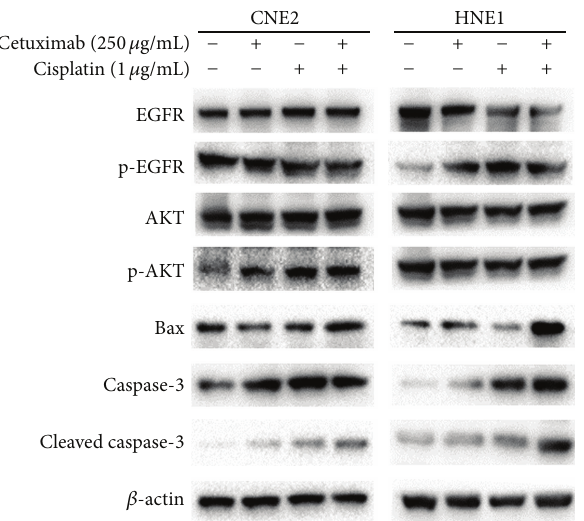
Figure 4: Effects of combination treatment with cetuximab and cis- platin on the expressions of proapoptosis proteins and EGFR/AKT signaling pathway proteins. Cells were treated with cetuximab, cisplatin, or the combination treatment of cetuximab and cisplatin for 48 h. The expressions of EGFR, p-EGFR, AKT, p-AKT, Bax, caspase-3, and cleaved caspase-3 in both cells were detected by Western blotting analysis. 𝛽 -actin was used as a loading